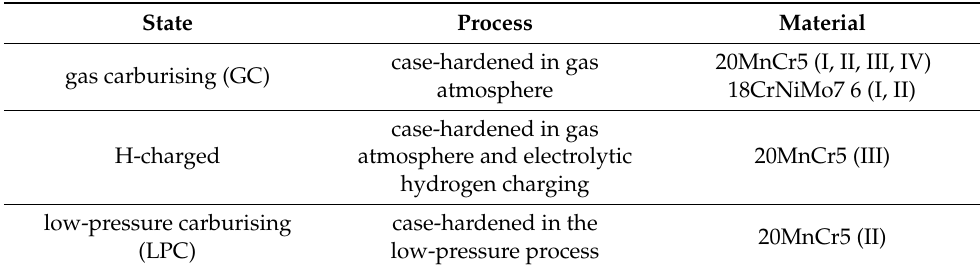
Table 2. Material states investigated for mechanical properties.